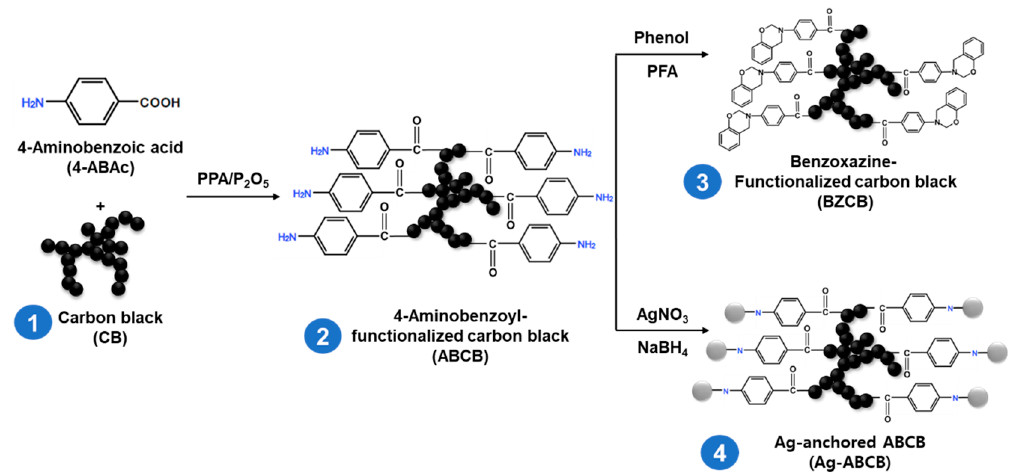
Figure 1. Schematic representation of the carbon black (CB) modification processes.